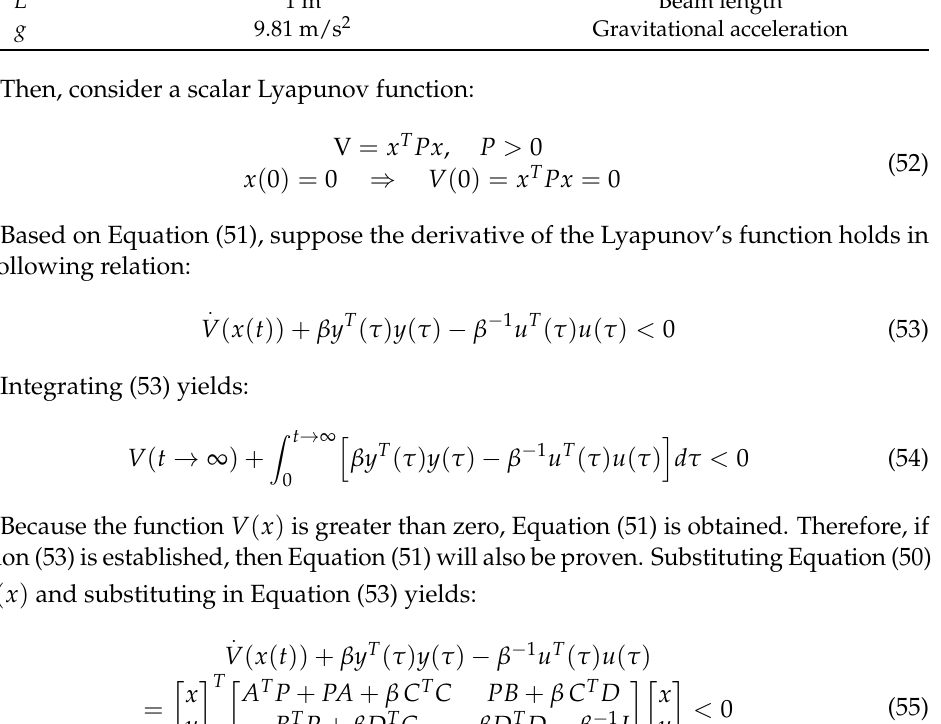
Table 1. Physical parameter values for the ball and beam system. m 0.11 kg ball mass M 1 kg beam mass J R 1 × 10 − 5 kgm 2 ball moment of inertia J 2 × 10 − 3 kgm 2 beam momemnt of inertia R 0.015 m ball radius L 1 m Beam length